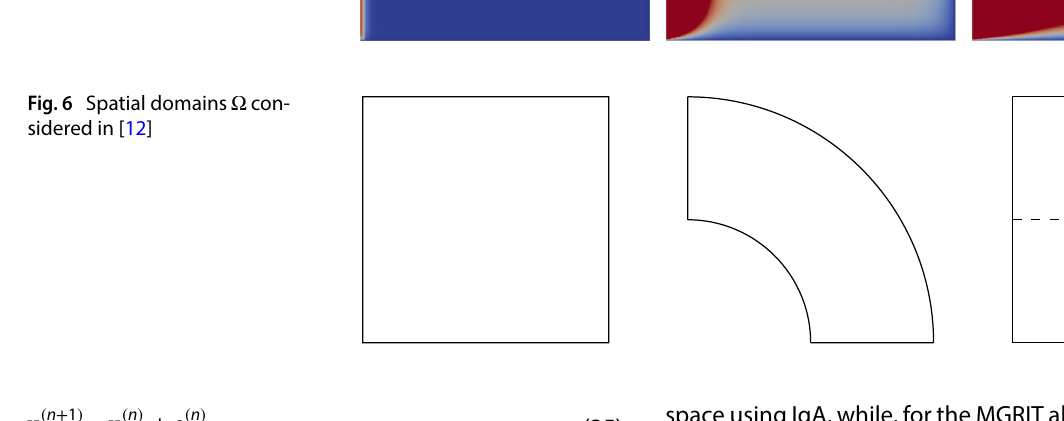
Fig. 6 Spatial domains Ω con- sidered in